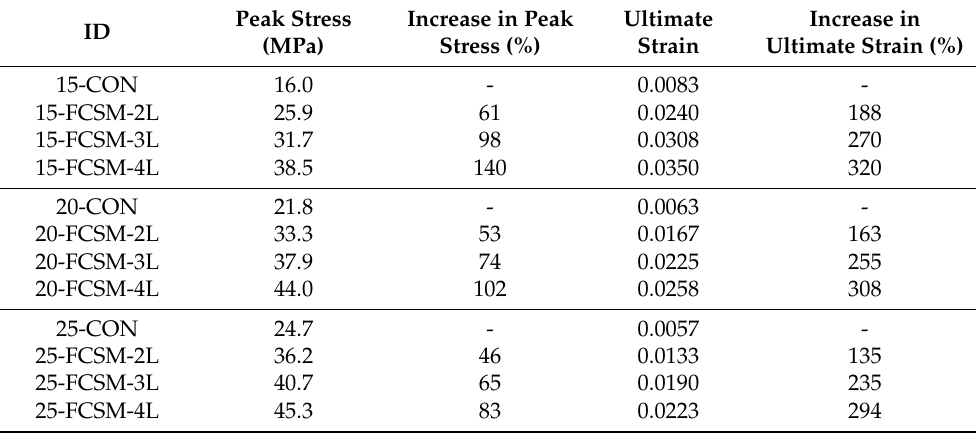
Table 3. Summary of peak compressive stress and ultimate